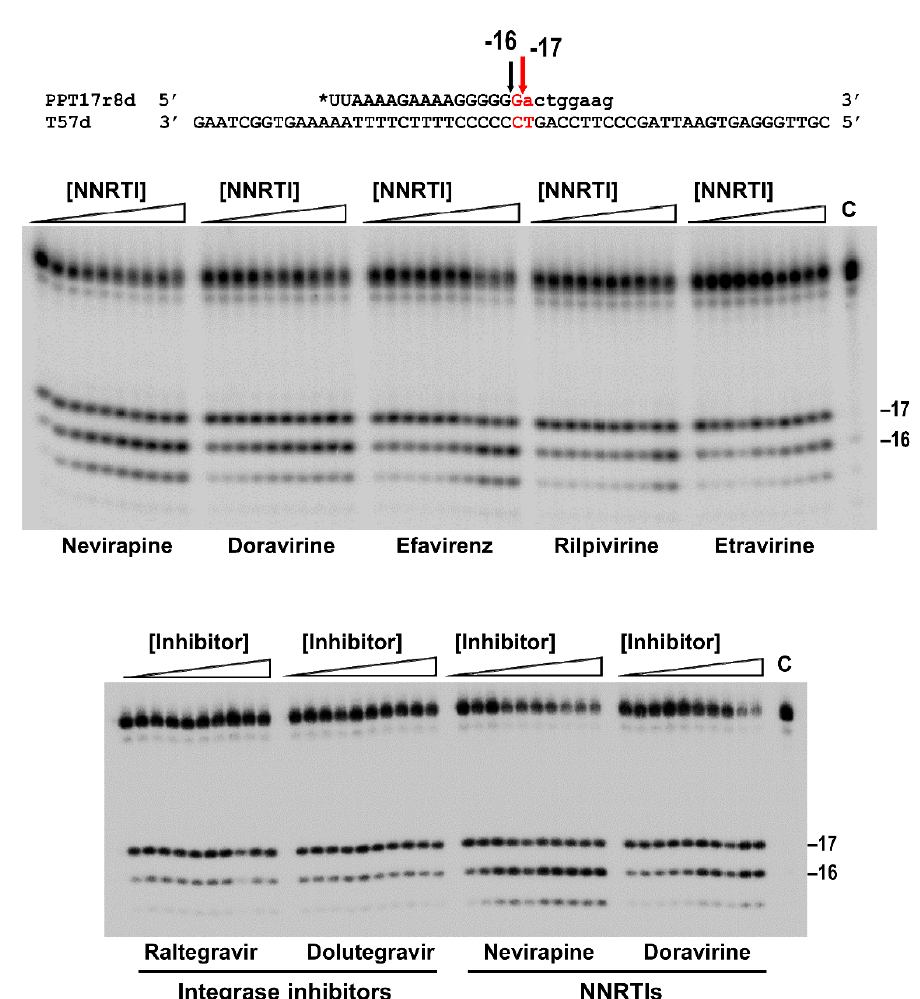
Figure 2. Cleavage of the chimeric PPT(RNA)-DNA oligonucleotide in the T57d/PPT17r8d complex in the presence of increasing concentrations of approved antiretroviral drugs. Assays were carried out with increasing concentrations of NNRTIs or integrase inhibitors: 0, 0.08, 0.16, 0.3125, 0.625, 1.25, 2.5, 5, 10 and 20 µM. Template-primer and WT HIV-1 BH10 RT concentrations in these assays were 25 and 125 nM, respectively. Aliquots were withdrawn after a 20 s-incubation. C stands for control (uncleaved PPT17r8d primer). Images show representative gels obtained from at least three independent experiments. Arrow and text in red indicate the location of the PPT/U3 cleavage site.